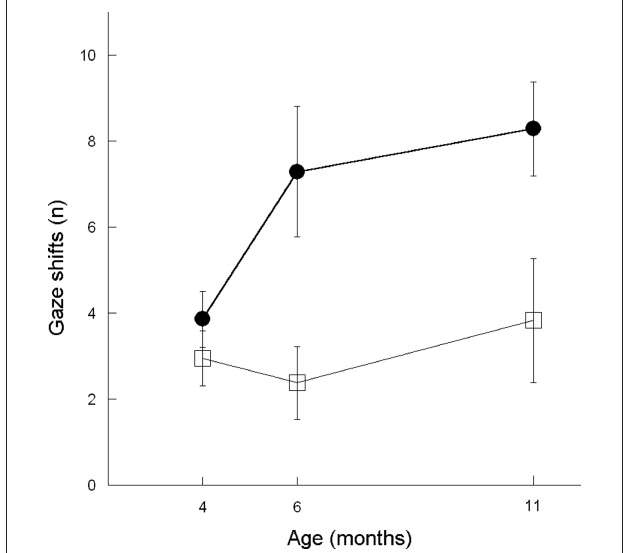
Figure 3 | Number of gaze shifts performed in accordance with the flow of conversation in face-to-face (closed circles) and back-to-back (open squares) conditions, error bars represent